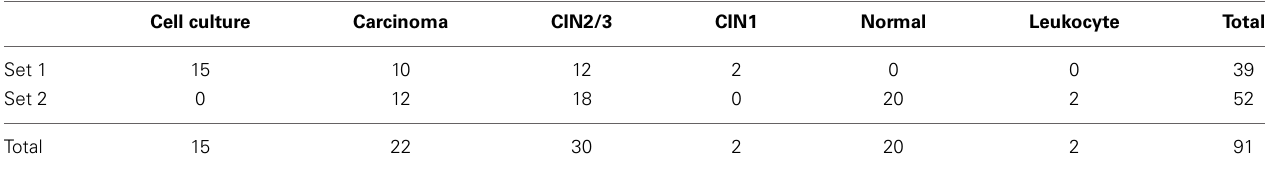
Table 1 | Overview of the histological sample groups and their